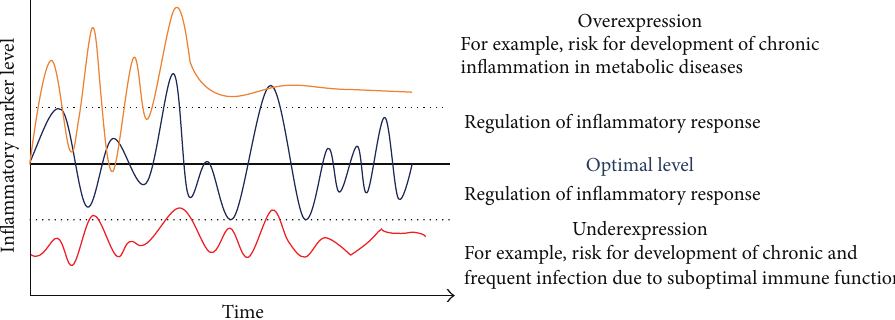
Figure 1: Illustration of general paradigm of the regulation of inflammatory